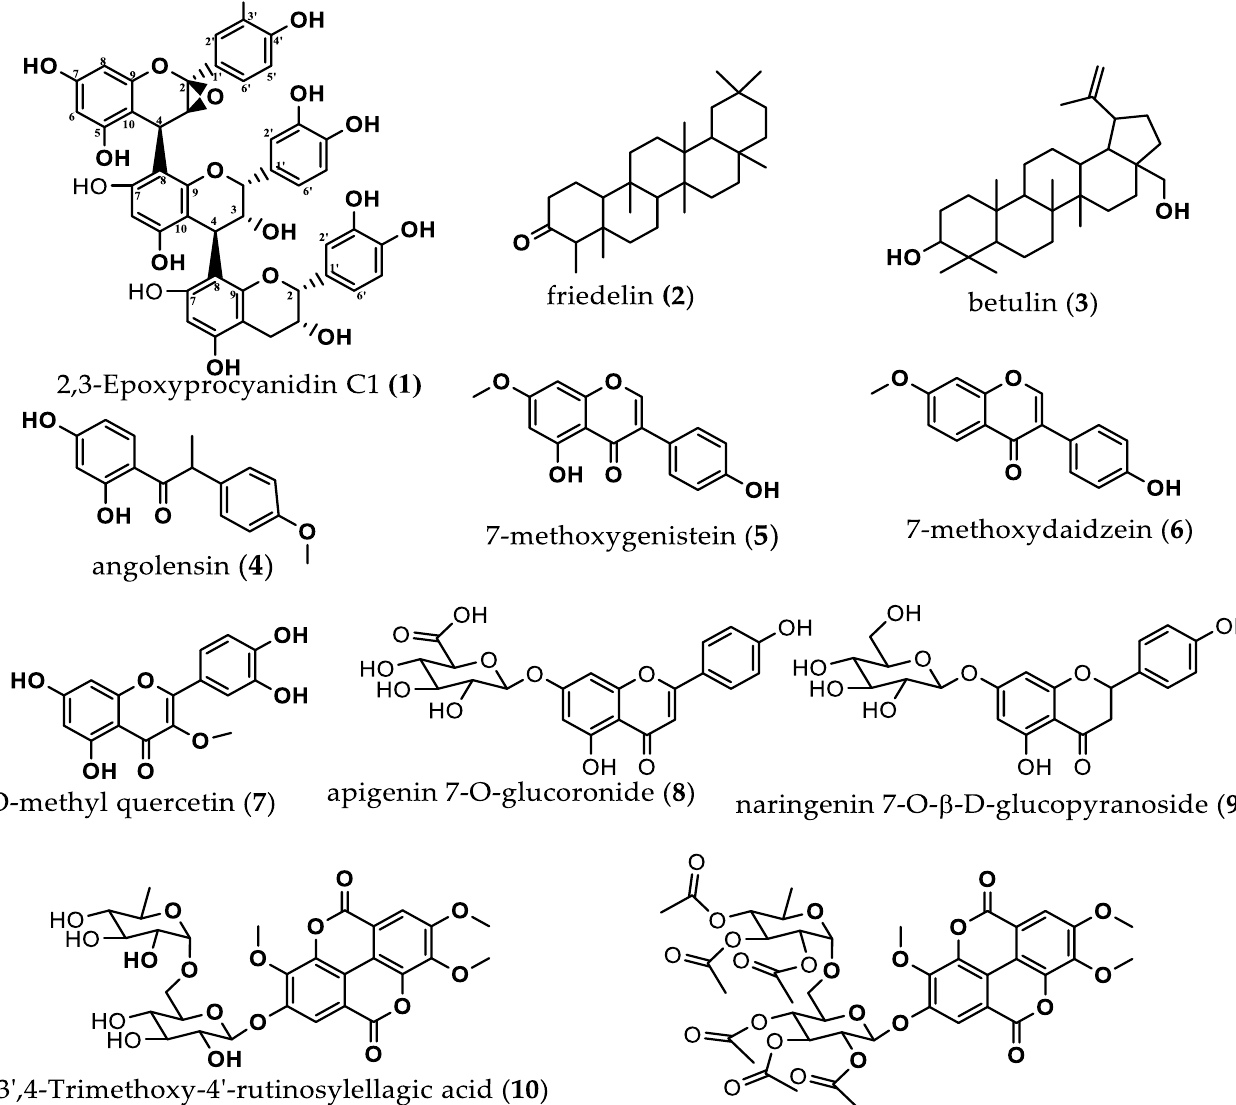
Figure 2. Structures of compounds isolated from roots of Pterocarpus erinaceus. Table 1. Spectral data of compound 1 : 1 H NMR and 13 C NMR with key HMBC and COSY. Units Position 13 C ( ppm )